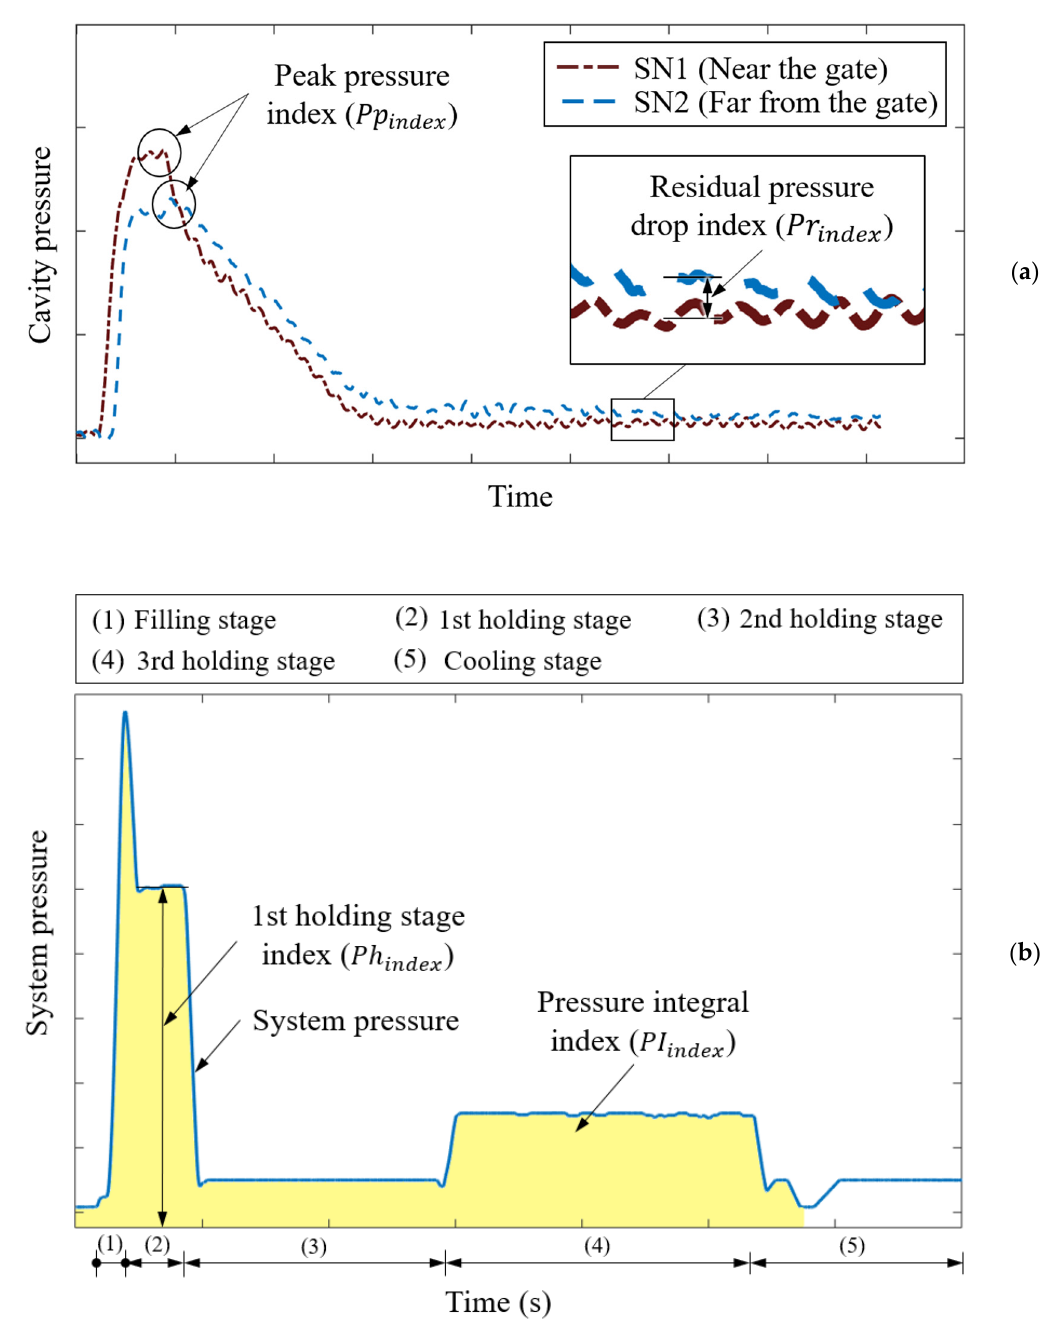
Figure 4. Quality indices: ( a ) peak pressure index ( Pp index ) and residual pressure drop index ( Pr index ); ( b ) pressure integral index ( PI index ) and first-stage holding pressure index ( Ph index ) . Table 2. Pearson correlation coefficients (PCCs) between geometric widths and quality indices. Quality Indices